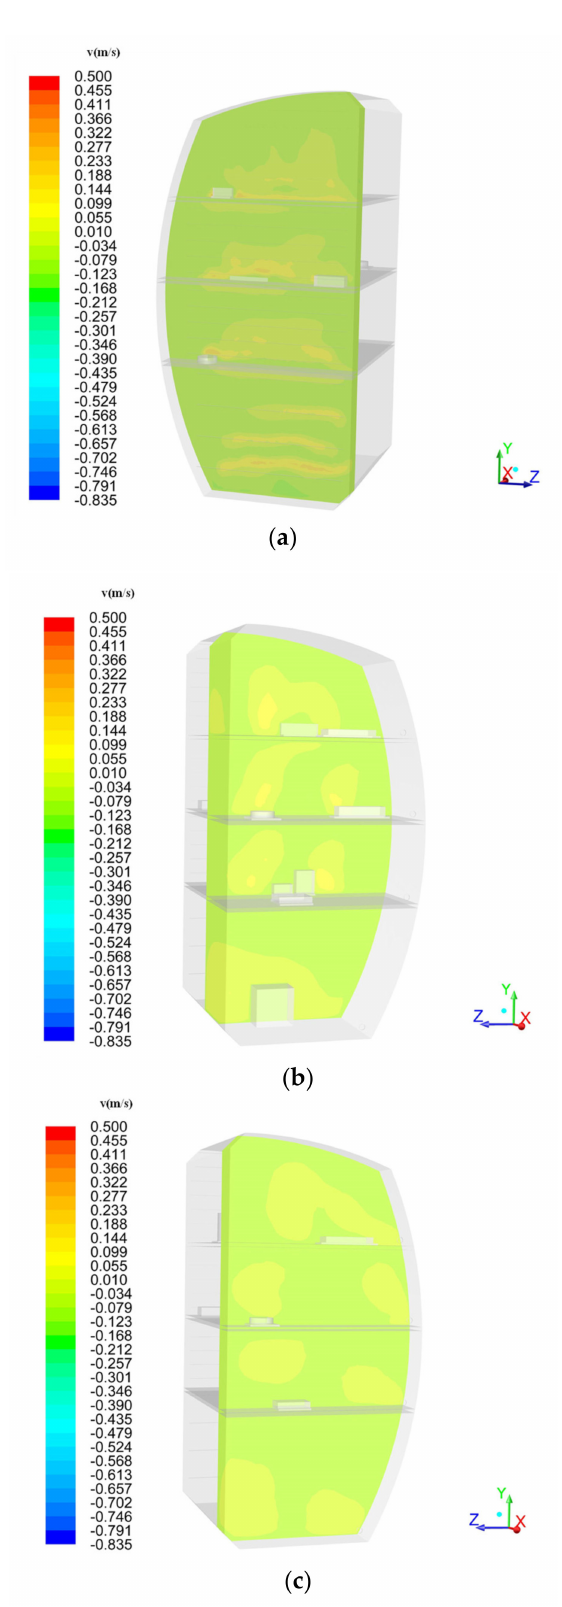
Figure 13. Velocity distribution in x direction of new air cooling system. ( a ) x = 120 mm, ( b ) x = 600 mm, and ( c ) x = 900